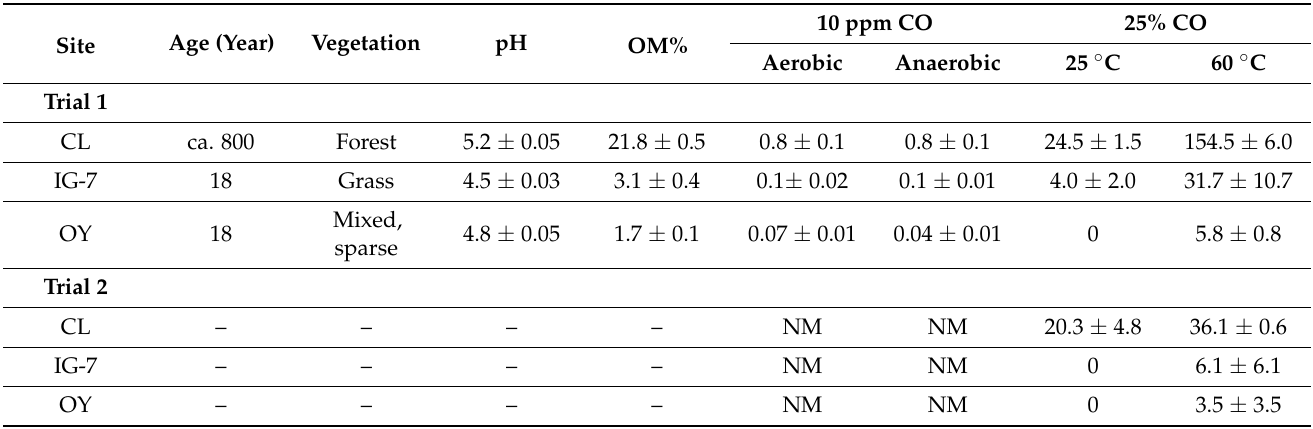
(Table 2). OY 60 ◦ C and IG-7 25 ◦ C uptake rates at 1% CO concentrations were 0.37 ± 0.02